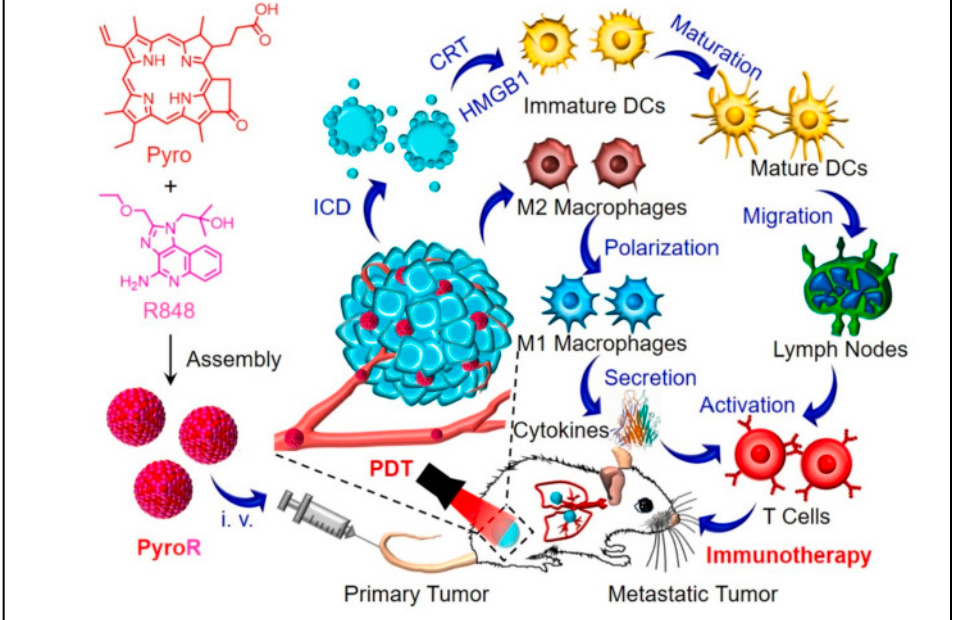
Figure 3. Schematic depiction of the self-assembly of PyroR and its mechanism of photodynamic treatment (PDT) causing immunogenic cell death (ICD) and macrophage polarisation. Pyro and